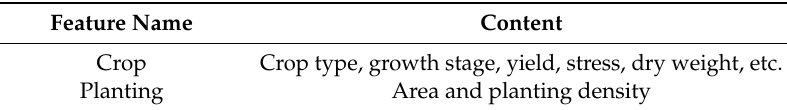
Table 2. Key features of crop/plant related data in agricultural cases.